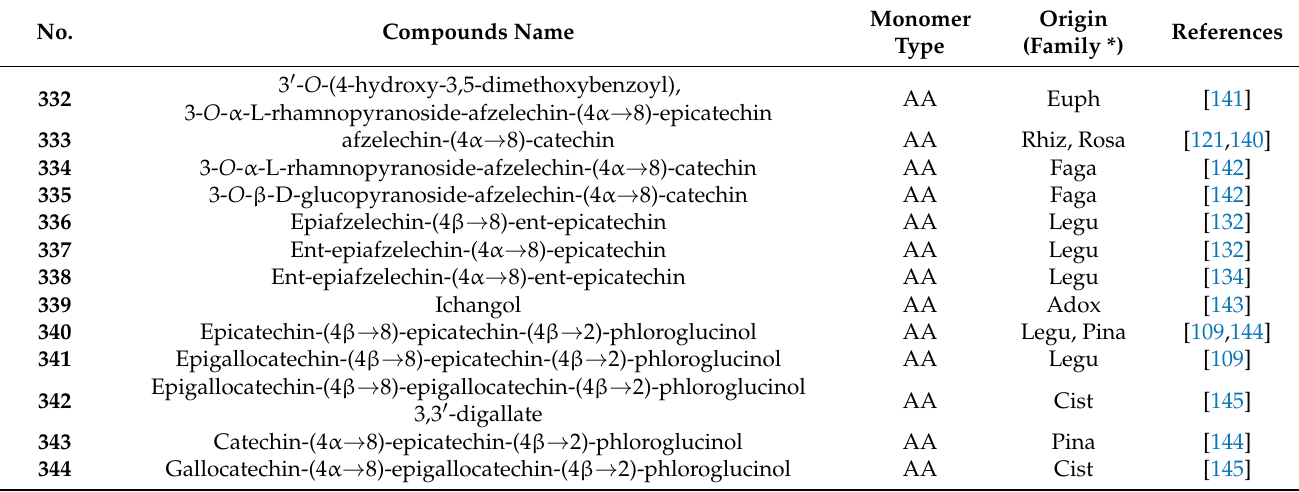
Figure 5. The structure of 3 (cid:48) -8 (cid:48)(cid:48) type biflavonoids. Table 7. The 4-8 (cid:48)(cid:48) subtype of